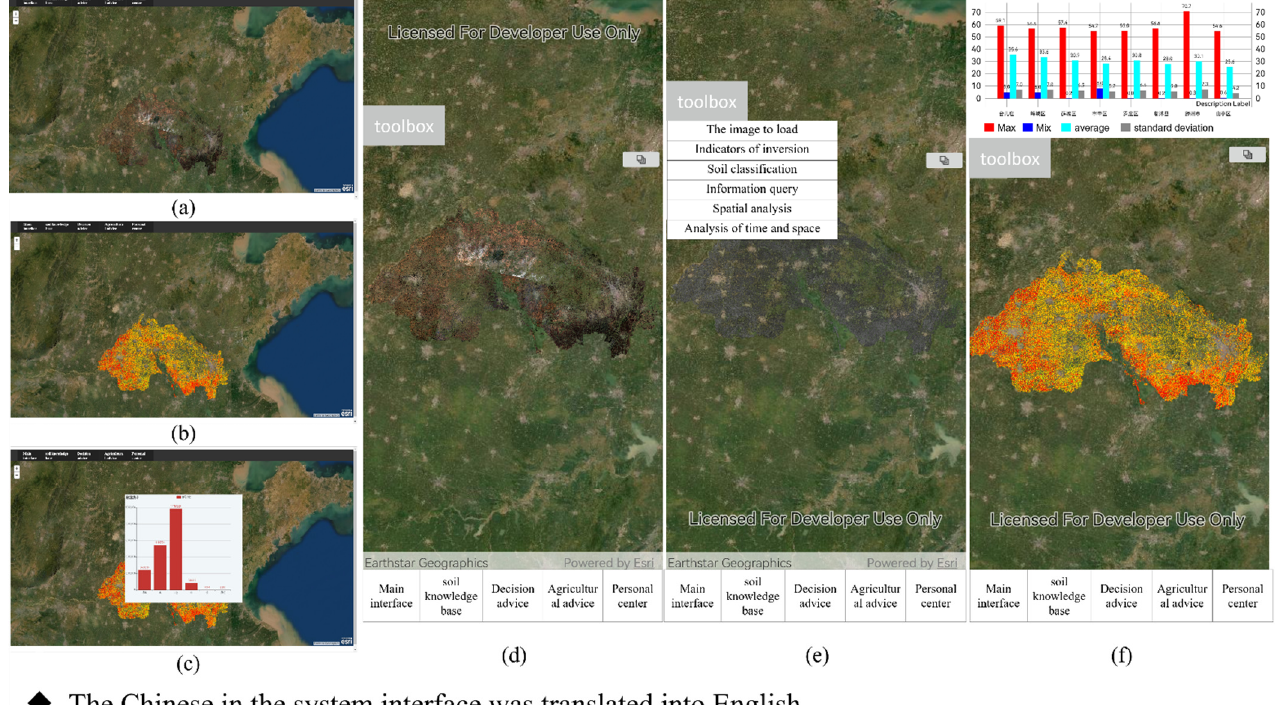
Figure 4. Intelligent inversion and spatial distribution of soil organic matter in southwestern Shan- dong Province, China. ( a ) The Web client loads the image; ( b ) The Web client hierarchical mapping; ( c ) The Web client spatial analysis; ( d ) The Mobile APP loads the image; ( e ) The Mobile app inversion results; ( f ) The Mobile APP hierarchical analysis. Table 1. Statistical results of soil organic matter classification in Southwest Shandong, China.